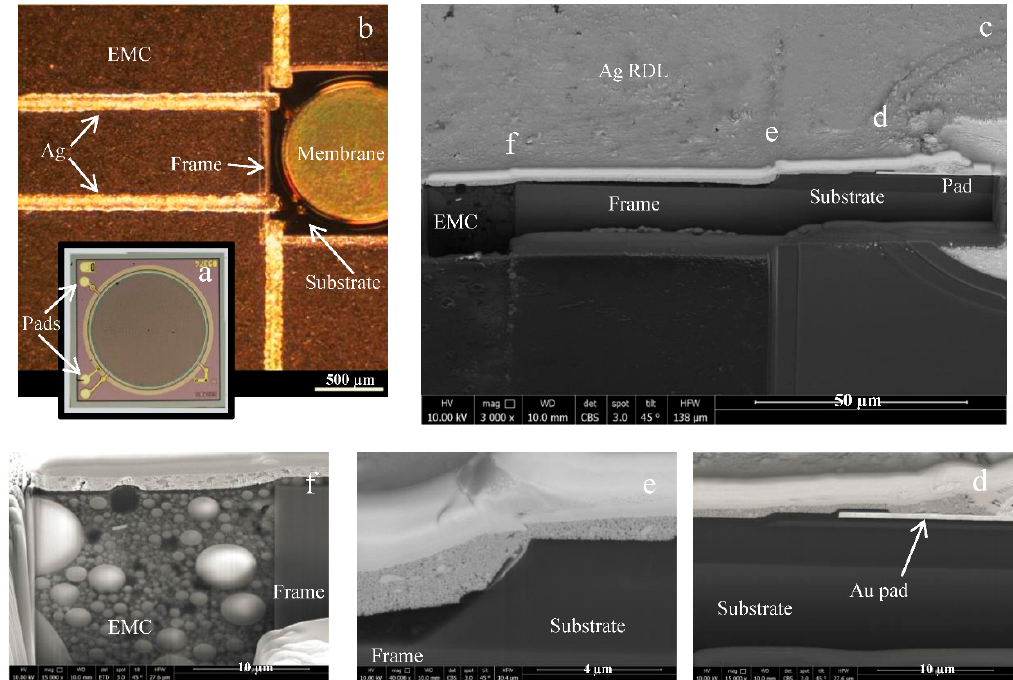
Figure 3. An example for inkjet-printed RDLs in FOWLP; a microphone chip with 4 pads before molding. ( a ) and a molded one with Ag RDLs ( b ); the corresponding FIB-cut cross-sectional view ( c